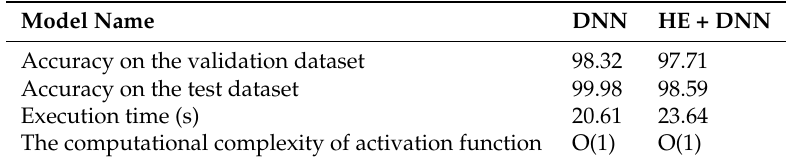
Table 2. Evaluation of homomorphic encryption deep learning model for classification problem (fault